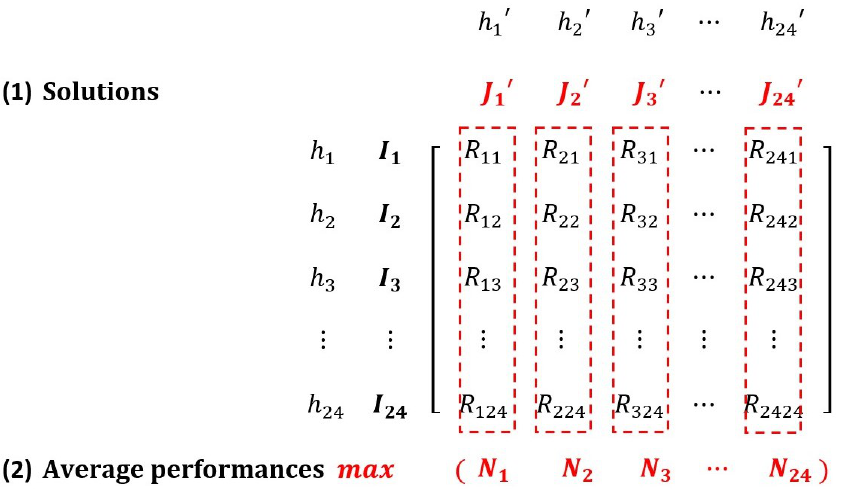
Figure 1. A Matrix Describing the Process of the Overlayed Spatio-Temporal Optimization. Both h 1 , h 2 , h 3 , . . . , h 24 and h (cid:48) , h (cid:48) , h (cid:48) , . . . , h (cid:48) refer to 24 h a day. I 1 , I 2 , I 3 , . . . , I 24 indicate 24 hourly sets of 2 3 1 24 POI visitor distribution. J (cid:48) , J (cid:48) , J (cid:48) , . . . , J (cid:48) represents 24 hourly AED solutions computed based on the 2 3 1 24 visitor distribution of the hour itself. R hh (cid:48) ( h , h (cid:48) ∈ 1,2,3, . . . ,24 ) means the optimized AED coverage rate applying the h (cid:48) th solution on h th set of POI visitor distribution. N 1 , N 2 , N 3 ,..., N 24 means the 24 average performances for each solution. For instance, N 1 is averaged over R 11 , R 12 , R 13 ,... R 124 , and N 2 , N 3 ,..., N 24 is calculated